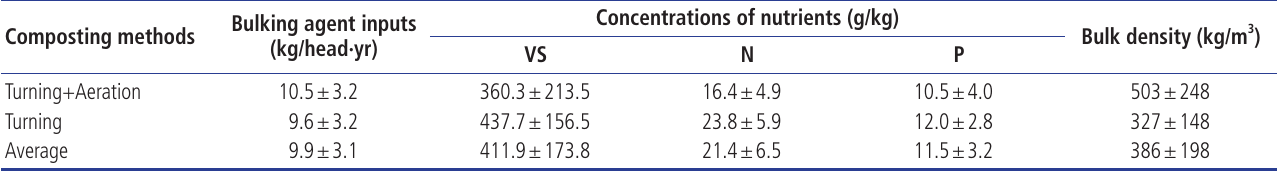
Table 4. Composting methods and concentrations of nutrients in solid compost Composting